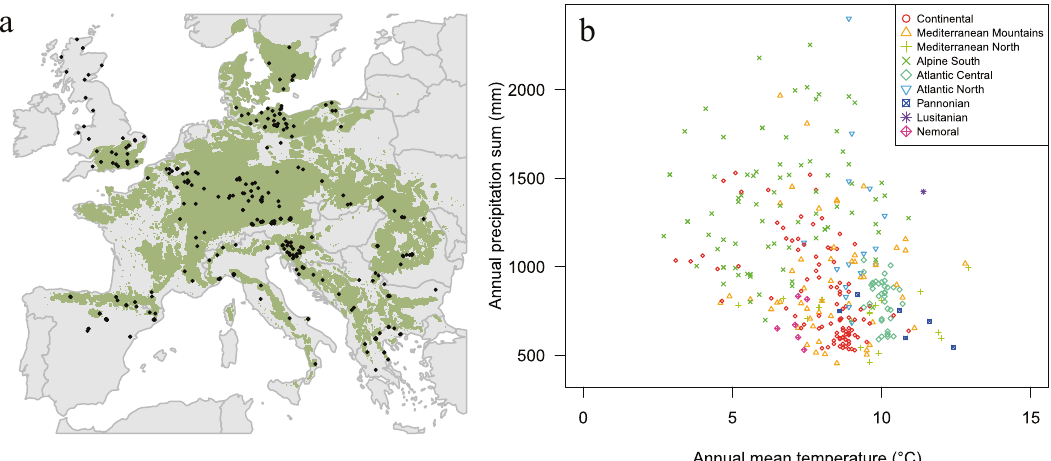
Fig. 1 Spatial and climatic range of beech sites. a Geographical distribution of the 324 study sites (black dots) in the natural distribution range of European beech (green area based on the EUFORGEN map 65 ; see Supplementary Data 2 for details). b Climatic envelope of European beech sampling sites, considering annual temperature and precipitation. Sites are labelled according to the environmental zones detailed in Metzger et al. 69